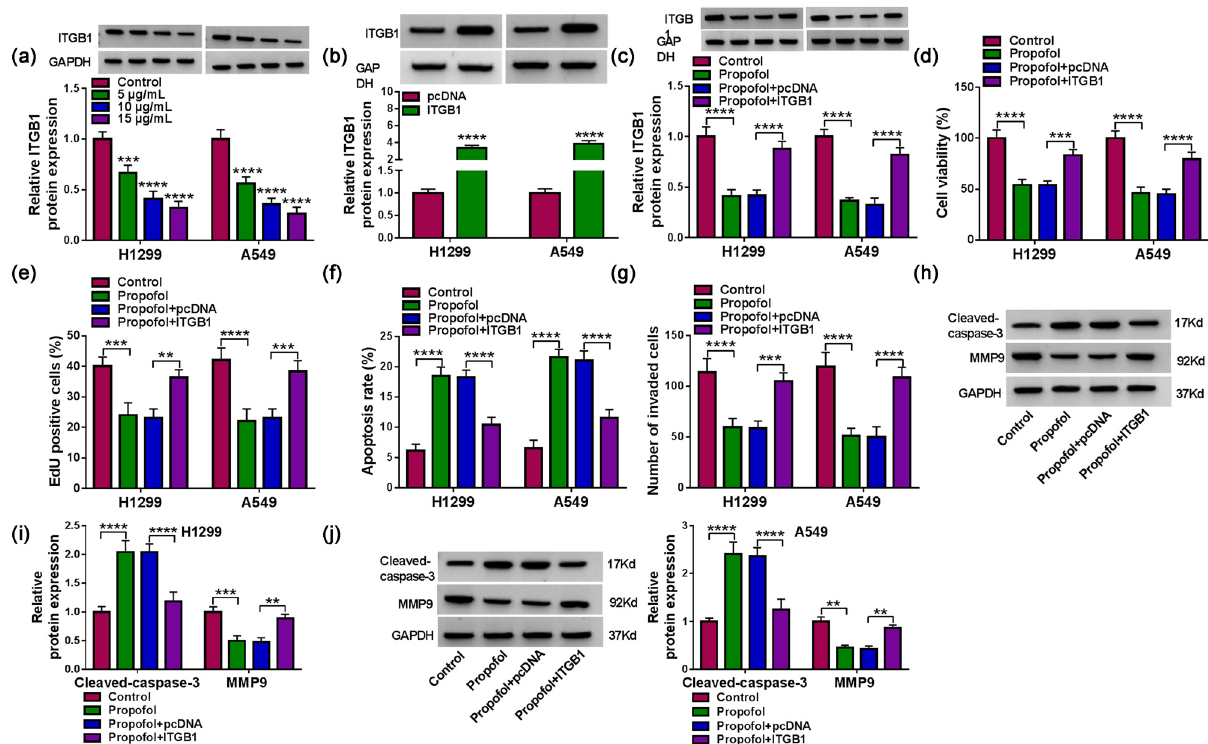
Figure A2: Propofol controlled NSCLC cell proliferation, invasion, and apoptosis by miR - 153 - 3p. ( a ) Detection of miR - 153 - 3p in NSCLC cells treated with 5, 10, and 15 μ g/mL propofol using RT - qPCR ( n = 3 ) . ( b ) Assessment of the transfection e ffi ciency of miR - 153 - 3p inhibitor using RT - qPCR ( n = 3 ) . ( c ) In fl uence of miR - 153 - 3p inhibitor on miR - 153 - 3p expression in propofol - treated NSCLC cells was evaluated using RT - qPCR ( n = 3 ) . ( d – g ) E ff ects of miR - 153 - 3p silencing on propofol - treated NSCLC cell viability, proliferation, apoptosis, and invasion were evaluated using MTT, EdU, fl ow cytometry, and transwell assays ( n = 3 ) . ( h – j ) Western blotting analysis of the impacts of miR - 153 - 3p knockdown on protein levels of Cleaved - caspase3 and MMP9 in propofol - treated NSCLC cells ( n = 3 ) . * P < 0.01, ** P < 0.01, *** P < 0.001, and **** P <